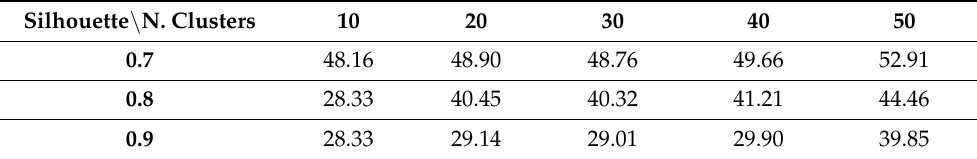
Table 24. Clustering performance in terms of silhouettes using the reduced dataset with SPQR applied to normalized data. Silhouette \ N.